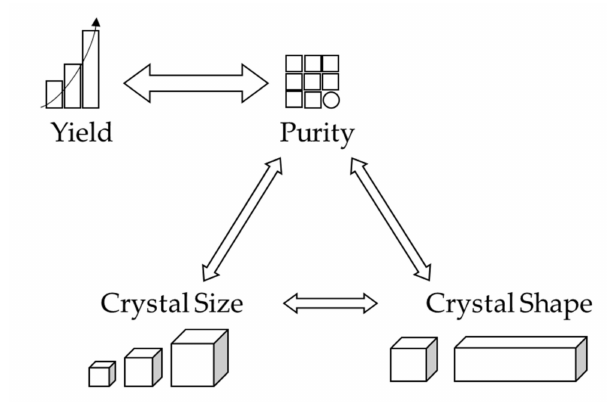
Figure 1. Main requirements for industrial crystallization